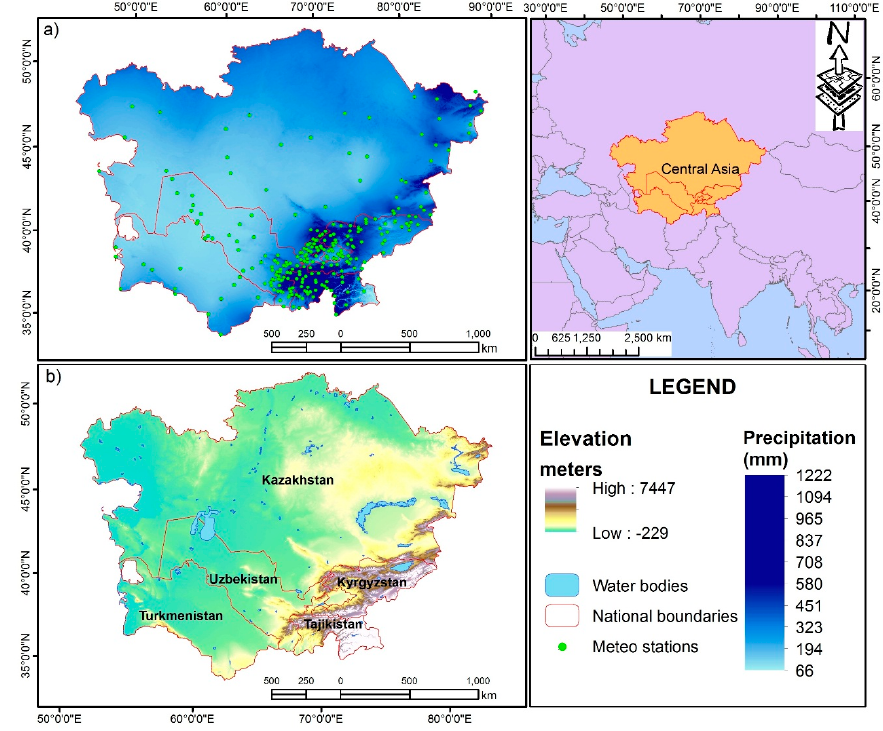
Figure 1. Study area: ( a ) Mean annual precipitation from WorldClim and ( b ) elevation from Shuttle Radar Topography Mission Digital Elevation Model (SRTM DEM, 90 m).